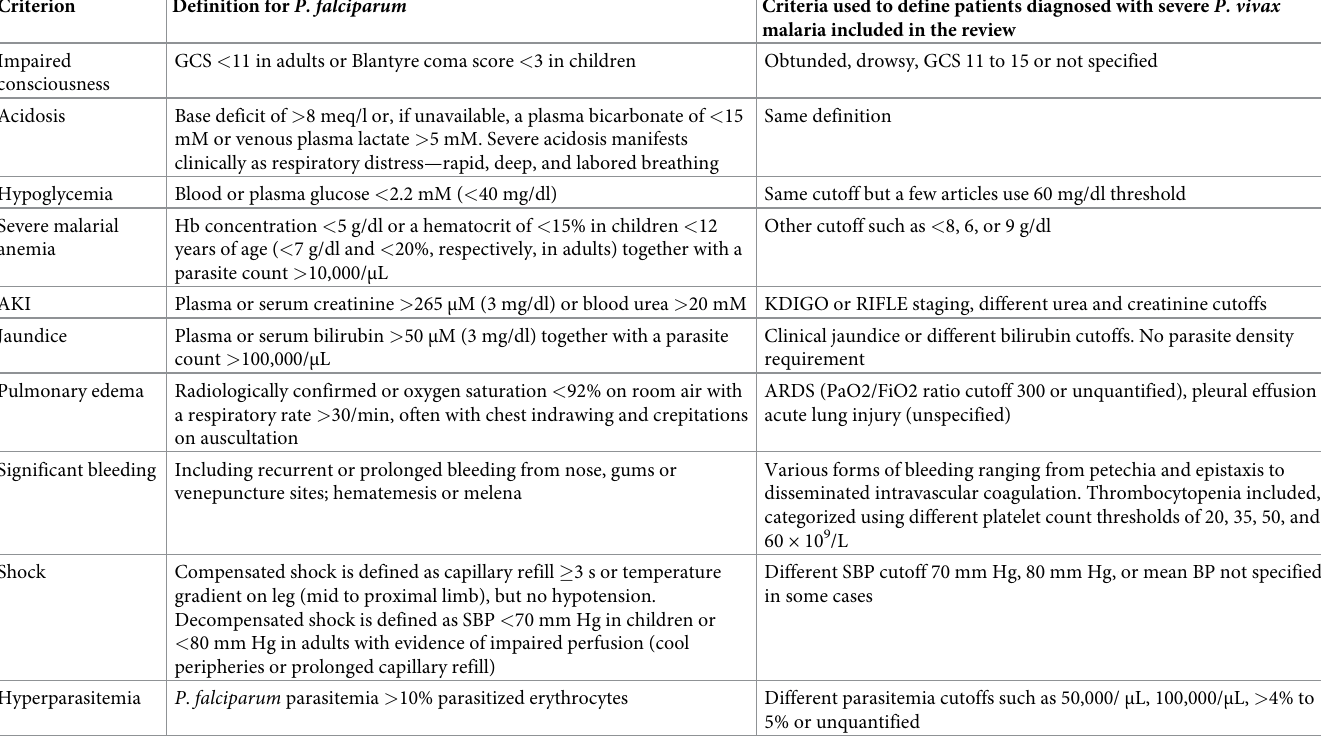
Table 1. WHO definition of severe falciparum malaria and common adaptations used to report severe Plasmodium vivax malaria.